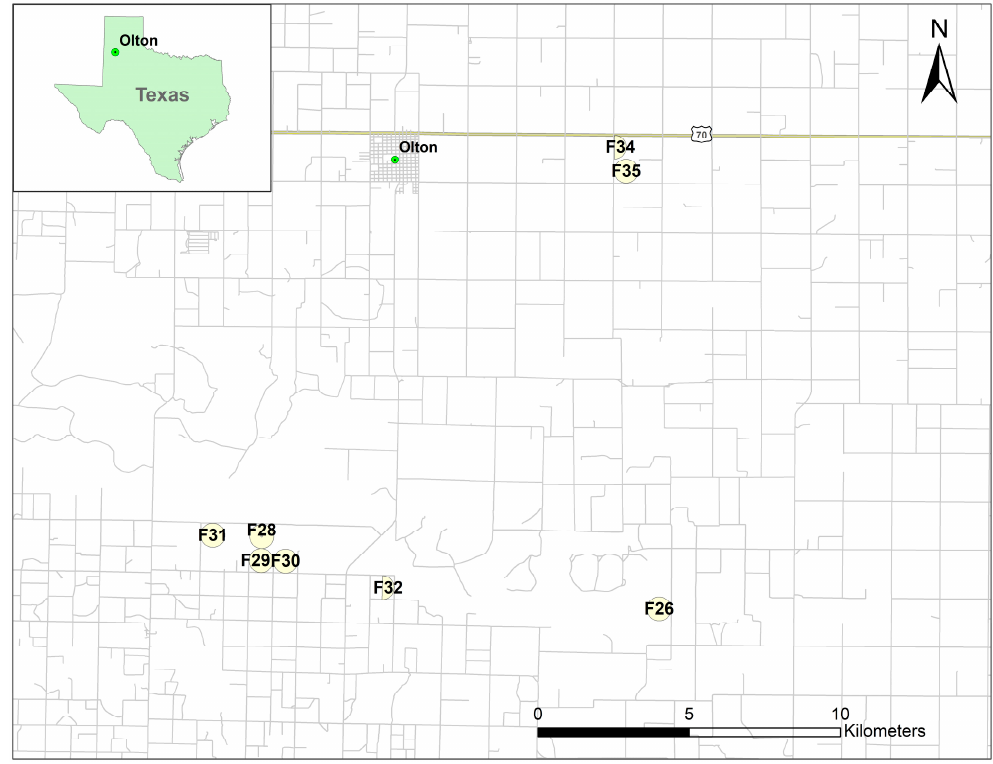
Figure 1. Locations of eight commercially managed irrigated fields for the study in the Southern High Plains.